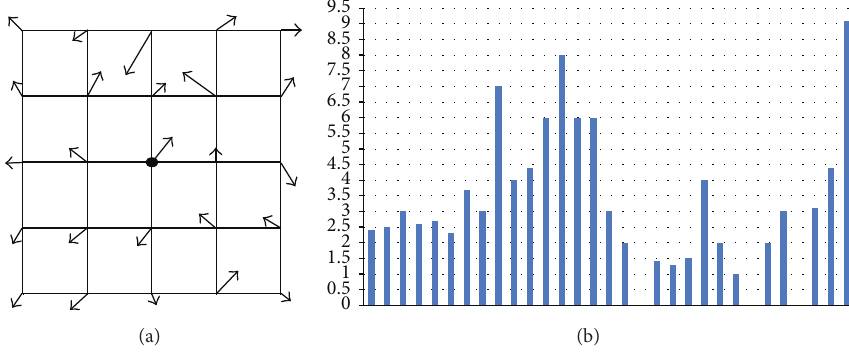
Figure 1: (a) The middle point is known as candidate key point and orientations to this point are computed using pixel differences. (b) The value of each bin holds the magnitude sums from all the points computed within that